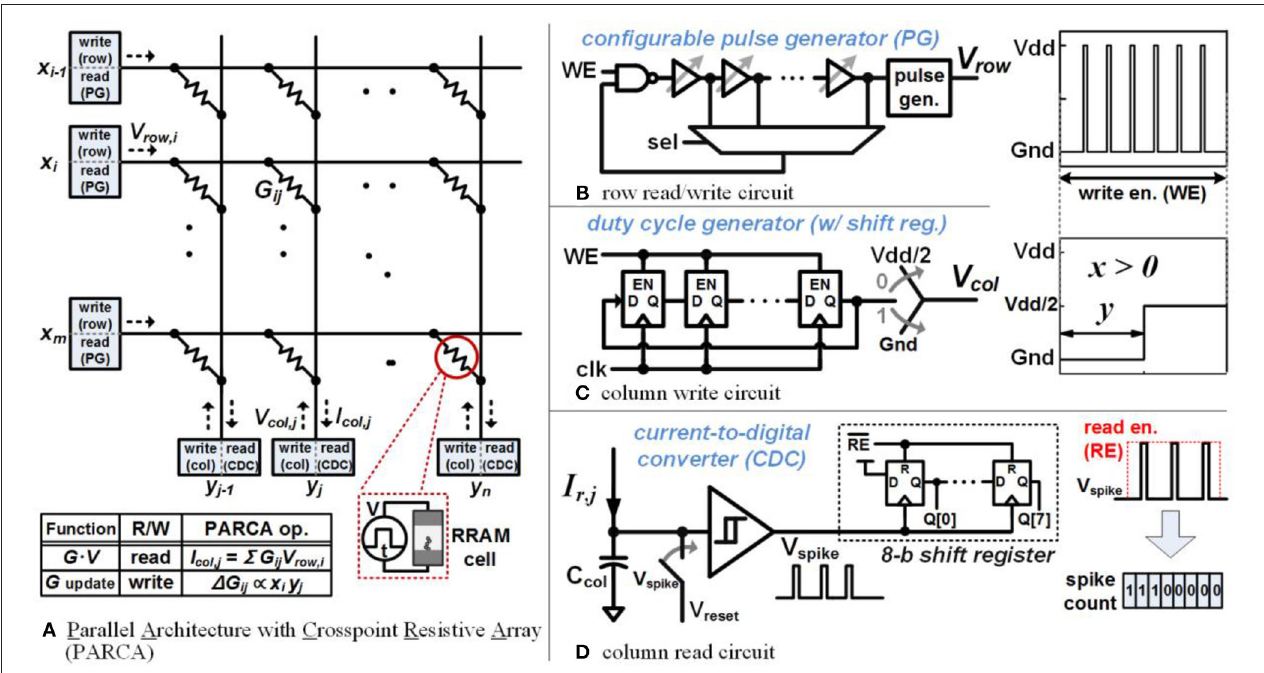
FIGURE 21 | Parallel architecture with resistive crosspoint array (PARCA). (A) Parallel architecture of resistive crosspoint array (PARCA) is shown. (B) Row read/write circuit modulates the number of pulses over time. (c) Column write circuit generates the duty cycle window where write is effective. (D) Column read circuit converts analog output current (weighted sum) into digital values. Adapted from (Seo et al.,